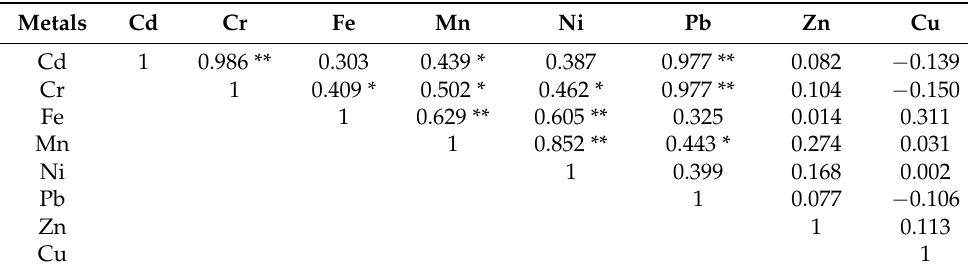
Table 9. Correlation matrix of metals in the vegetables.